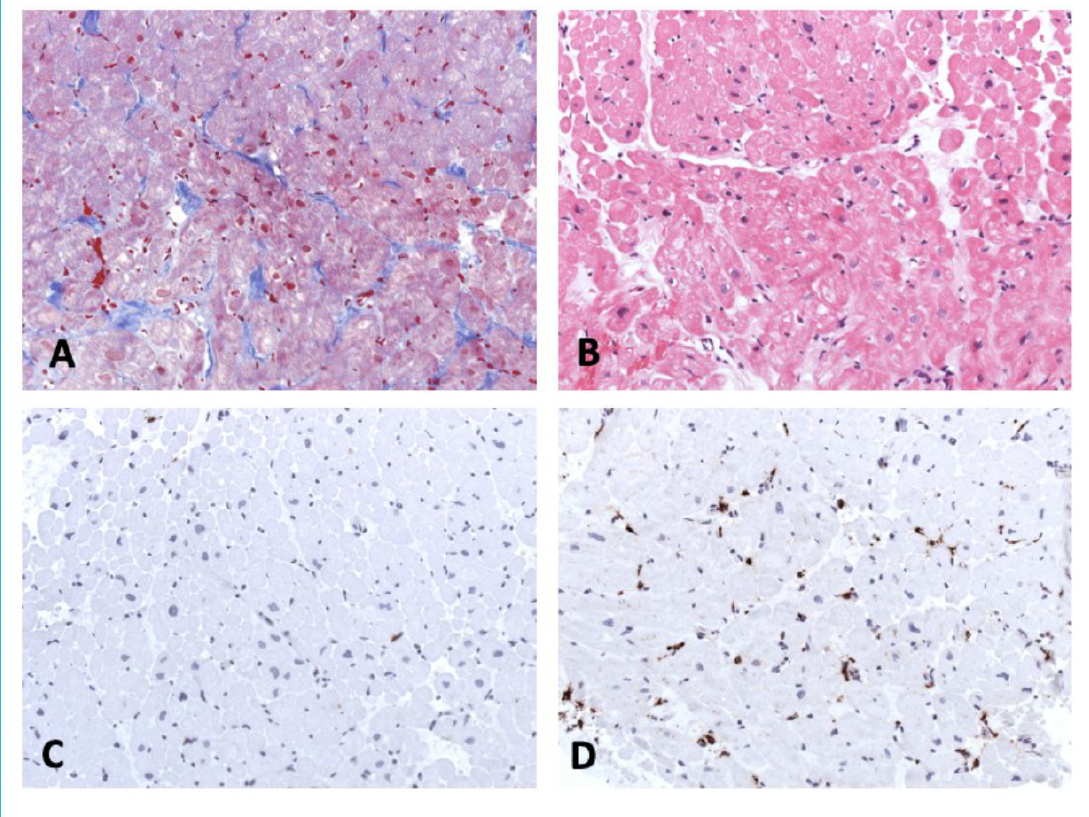
Figure 4: Endomyocardial biopsy. Masson trichrome staining (A),haematoxylin-eosin staining (B), immunohistochemistry for detection of CD3+ T cells (C) and CD68+ macrophages (D). Magnification